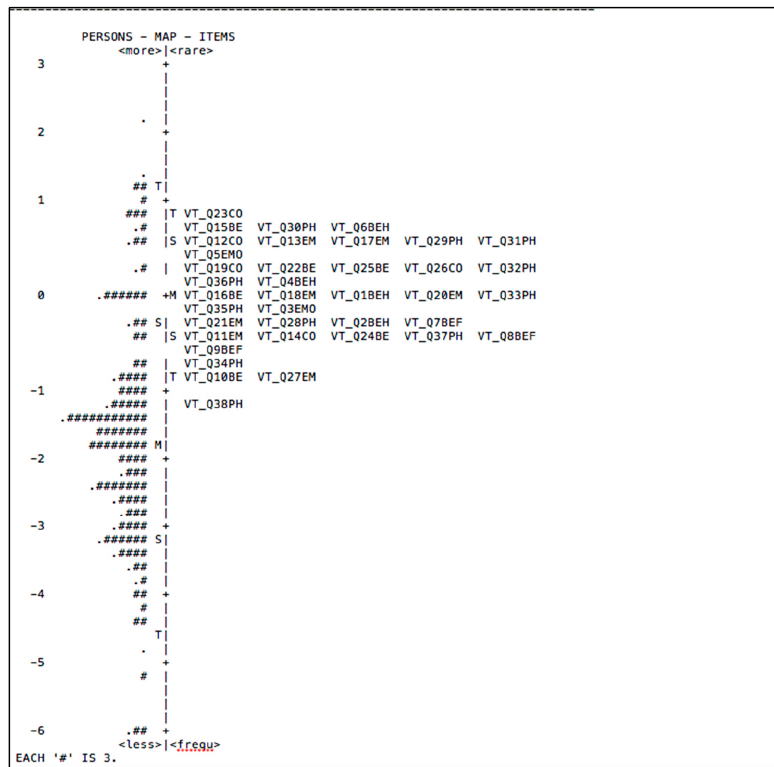
Figure 2. The item-person map of Vicarious Traumatization Questionnaire .